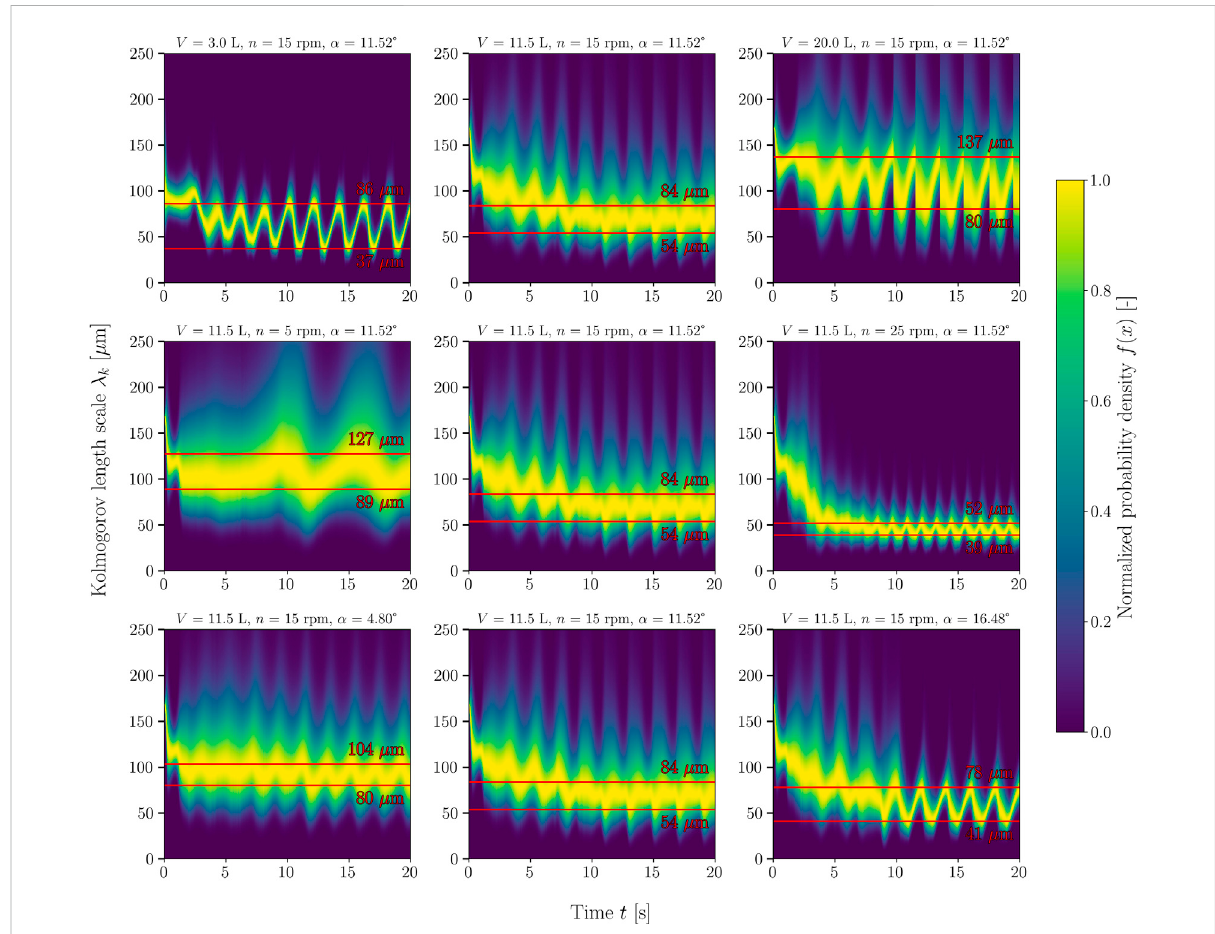
FIGURE 8 Temporal change of the relative probability density function of the Kolmogorov lengths. The respective process parameters are shown as the titlesoftheindividualdensitymaps.Inthetoprow,volumeincreasesfromlefttoright.Inthemiddlerow,therockingrateand,inthebottomrow,the rocking angle increase from left to right. In each case, the start-up process described in Section 2.3 can be seen in the fi rst 10 s. The lines marked in redindicatetheminimumandmaximummeanKolmogorovlengths(the fi rst10 swerenottakenintoaccount).Thefrequencydensityfunction was normalized so that the maximum frequency density for each time step equals